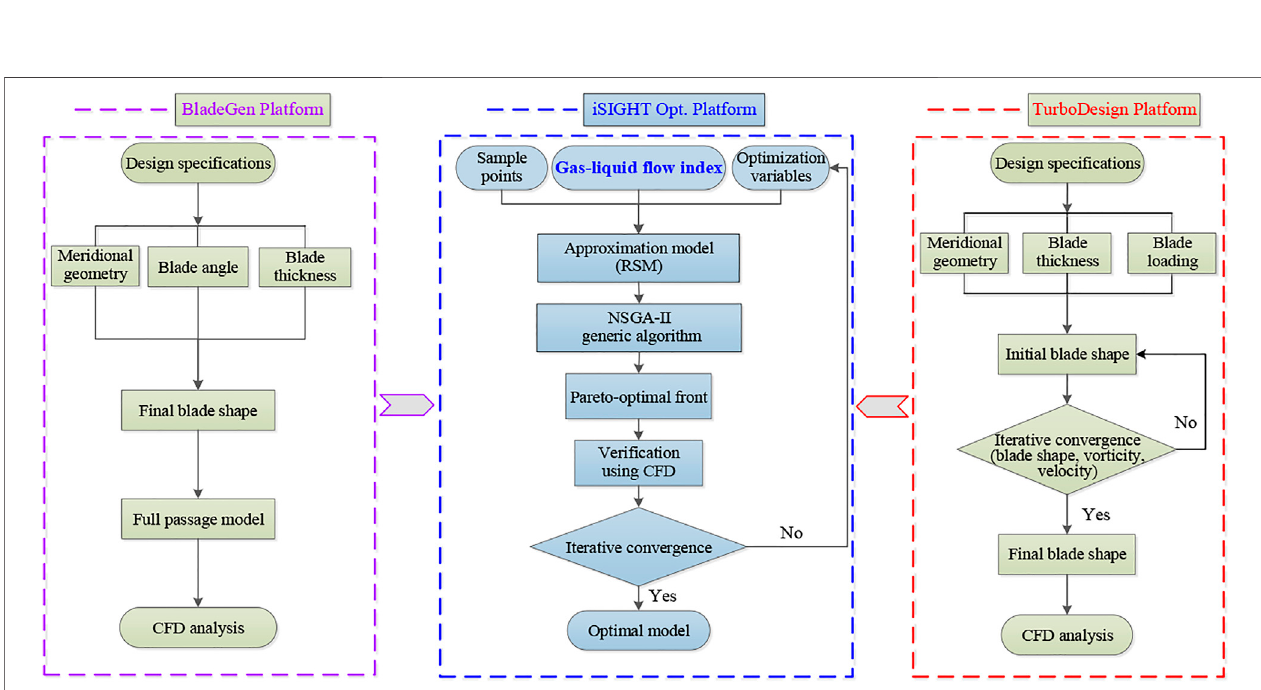
FIGURE 2 | Multi-objective optimization design system.